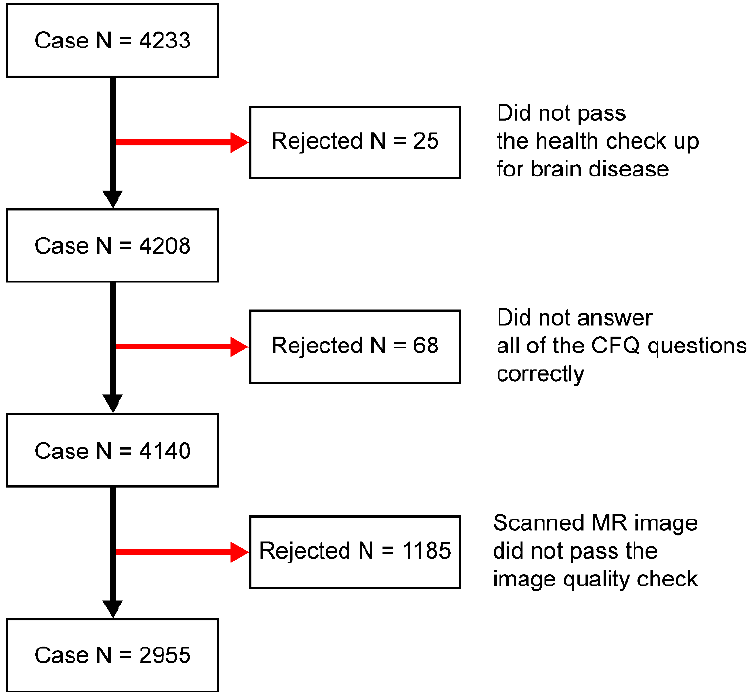
Figure 1. The participant-selection process.